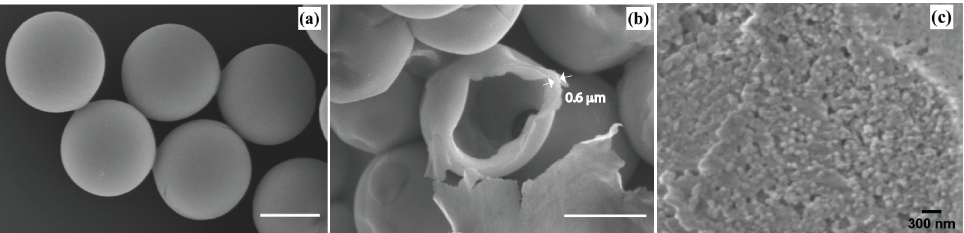
Figure 3. ( a ) SEM images of 16.5 µ m zinc oxide microcapsules obtained from 62 µ m droplets; ( b ) shell thickness was found to be approximately 0.6 µ m; ( c ) high-magnification SEM on shell microcapsules showing the size of ZnO NPs building blocks of approximately 100 nm. Scale bars: ( a , b ) 10 µ m, ( c ) 0.3 µ m.